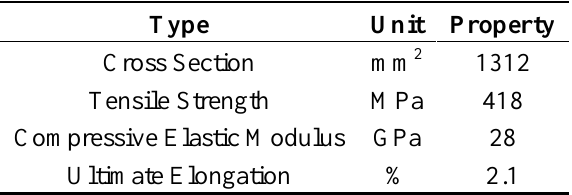
Table 1. Mechanical properties of the Glass fiber reinforced plastic (GFRP) composite beams.